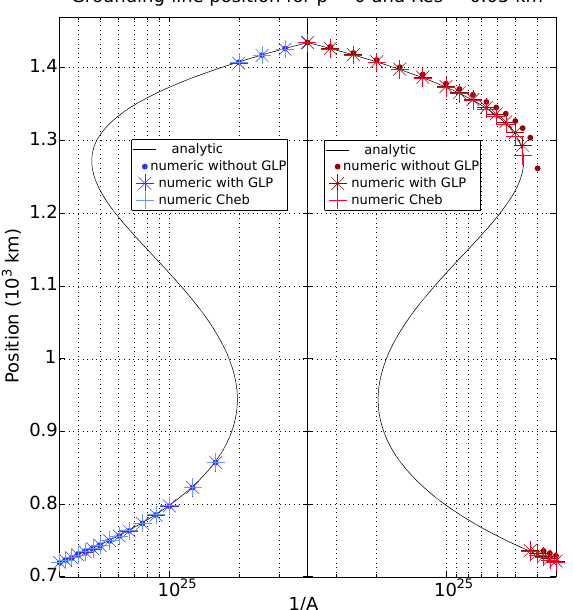
Figure 8. As in Fig. 5 but with the polynomial bed shown in Fig. 2a. The boundary-layer solution closely agrees with Chebyshev results (maximum difference of 1.4km). Fixed-grid results both with and without the GLP closely agree with the Chebyshev benchmark dur- ing advance (maximum difference of ∼ 1km without the GLP and ∼ 1.6km with the GLP). During retreat, the model with GLP is the better match to the benchmark (maximum difference of ∼ 14km). Without the GLP, the fixed-grid grounding-line position matches the benchmark reasonably well when both solutions are on the same side of the unstable region (maximum difference of ∼ 38km) but not in the vicinity of the local maximum where the solutions are on different side of the unstable region, (maximum difference of ∼ 570km).